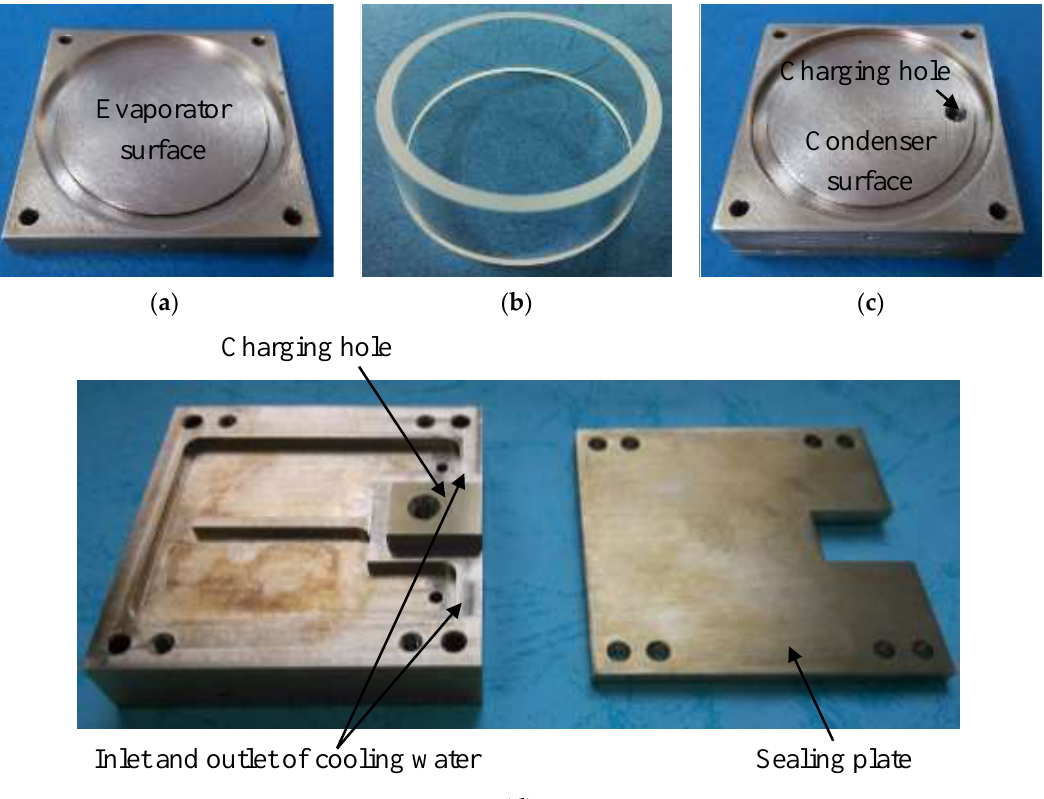
Figure 3. Structure of flat two-phase thermosyphon: ( a ) evaporator surface; ( b ) quartz glass tube; ( c ) condenser surface; and ( d ) cooling water tank at back of condenser section.